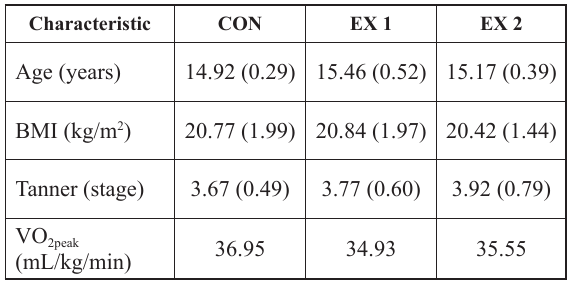
Table 1. Mean values (SD) for the basic characteristics of two experimental groups (EX 1 and EX 2) and control (CON)